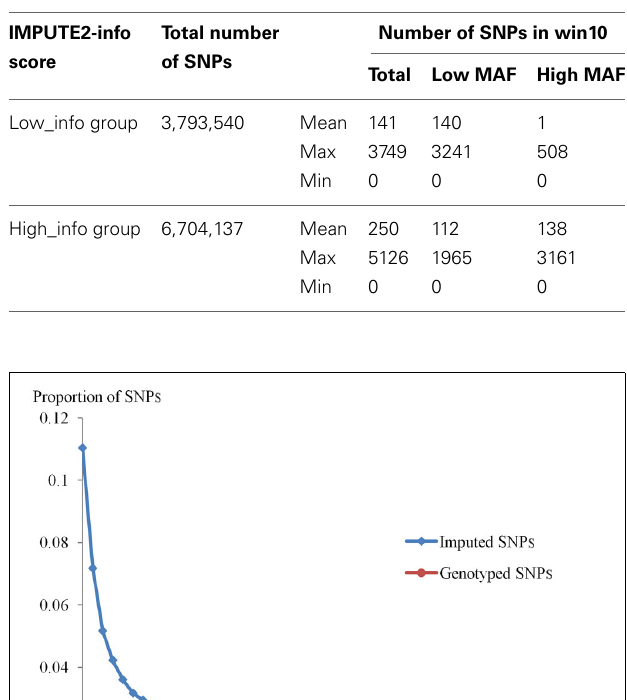
Table 2 | Total number of imputed SNPs and summary of SNP number in a window containing 10 genotyped SNPs (win10) for two different IMPUTE2-info scores in the simulation study.